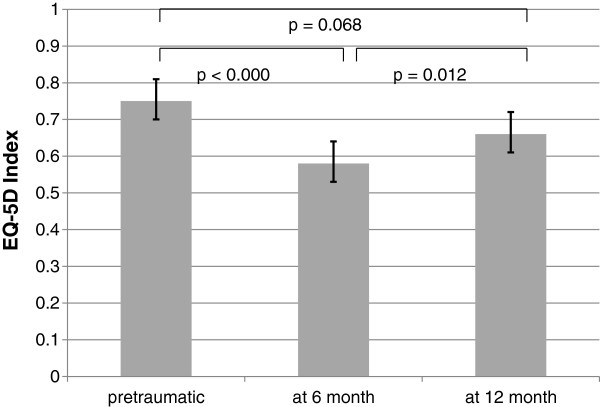
EQ-5D Index: pretraumatic, at 6 month follow up and at 12 month follow up.